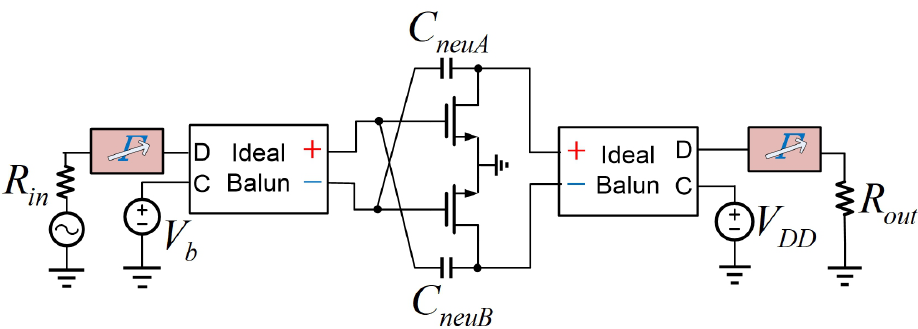
Figure 3. Schematic for optimal impedance extraction.